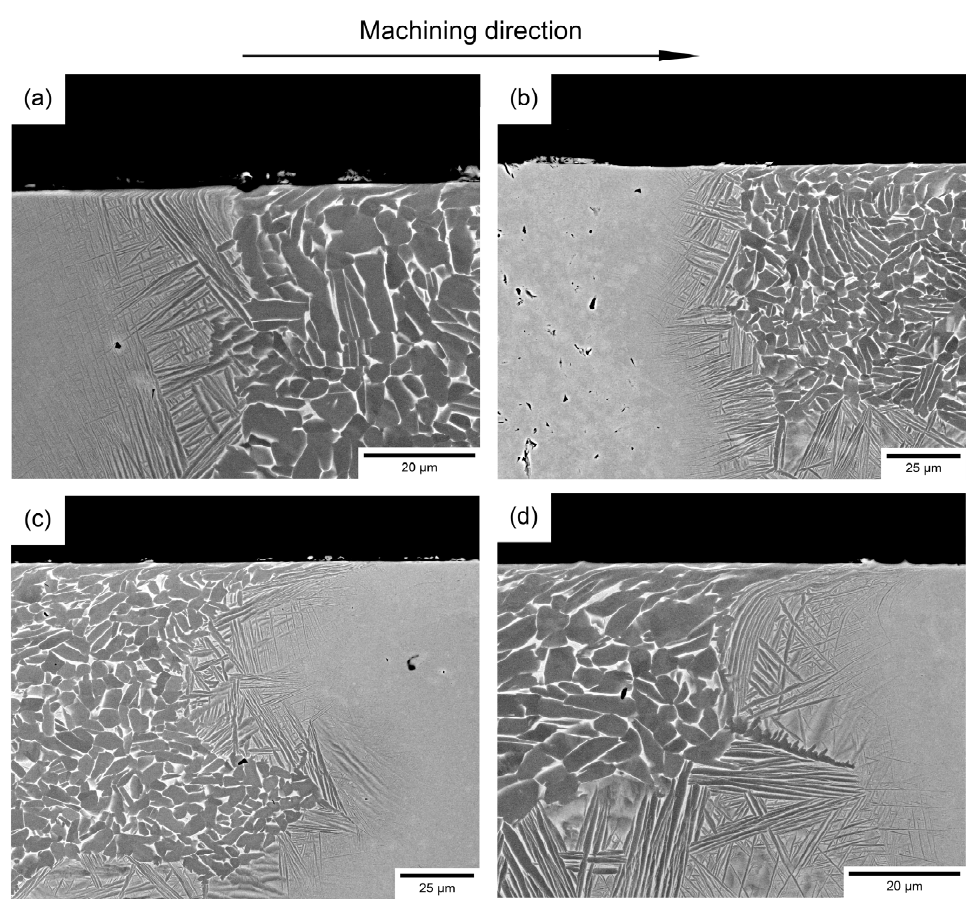
Figure 10. Backscattered electron micrographs of the cross section-induced damage for alloy bond pairings consisting of ( a , c ) Ti-5553/Ti-6242 and ( b , d ) Beta